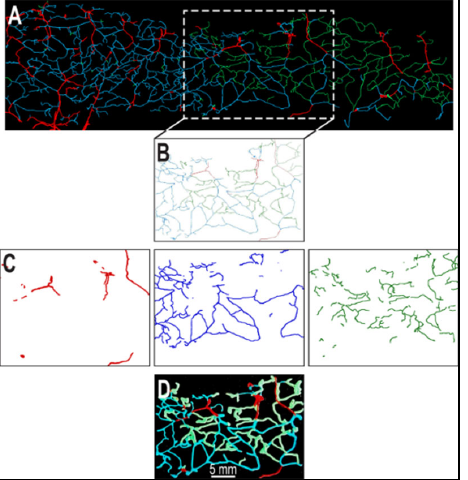
Figure 4. 3D Printing of the colonic vascular pattern. ( A ) The central region of the image, containing the overlap of the three ‘pseudo-generations’, was selected for further processing. ( B ) Inversion of the background for clarity and aid in generating .stl files in ( C ). ( C ) Separation and conversion of these three generations in individual .stl files. ( D ) Printing of the files in contiguity (overlapped) with a correspondingly colored surrogate bioink. Bar: 5 mm. Magnification in ( A – C ) is the same as in Figure 3.